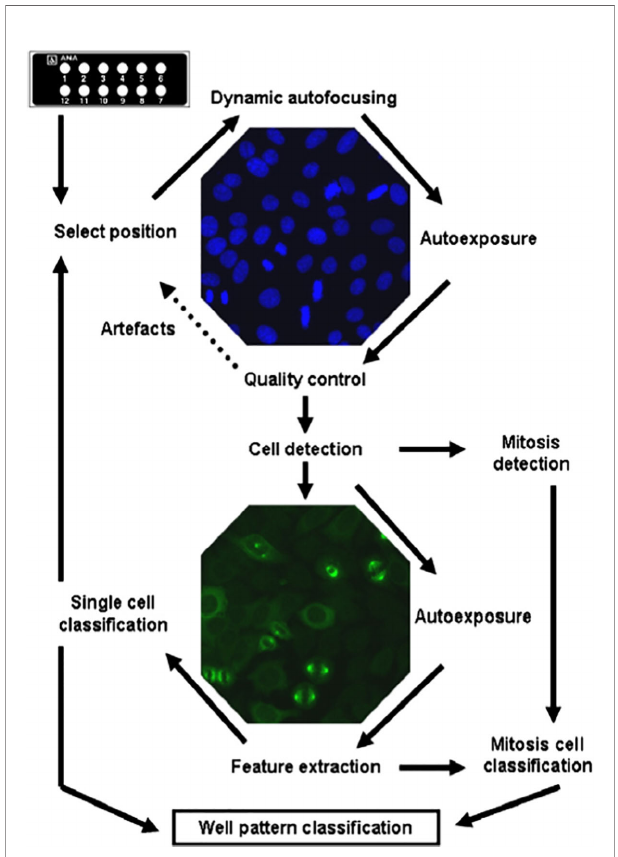
FIGURE 1 | Complete processing cycle of automated HEp-2 cells assay reading by Aklides system (reproduced from Hiemann R, et al. Challenges of automated screening and differentiation of non-organ speci fi c autoantibodies on HEp-2 cells. Autoimmunity Rev 2009; 9:17-22)